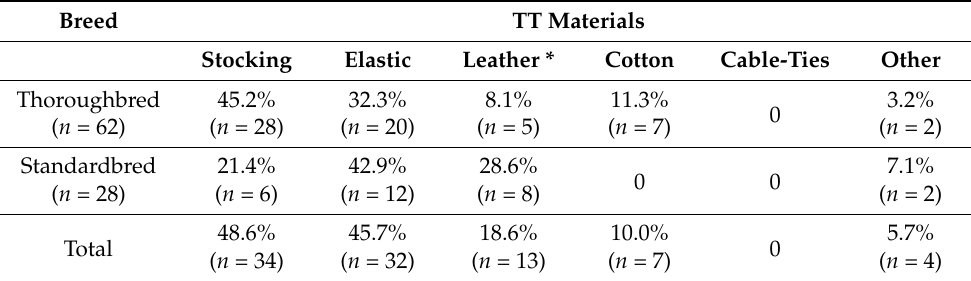
Table 1. The distribution n (%) of TT materials reported by respondents. The % reported in each cell represents the number of the type of TT reported over the total TT responses from TBTs ( n = 62) and SBTs ( n = 28). An asterisk * denotes a significant difference between the use of a type of TT by either TB or SB respondents. Note that respondents could select more than one type of